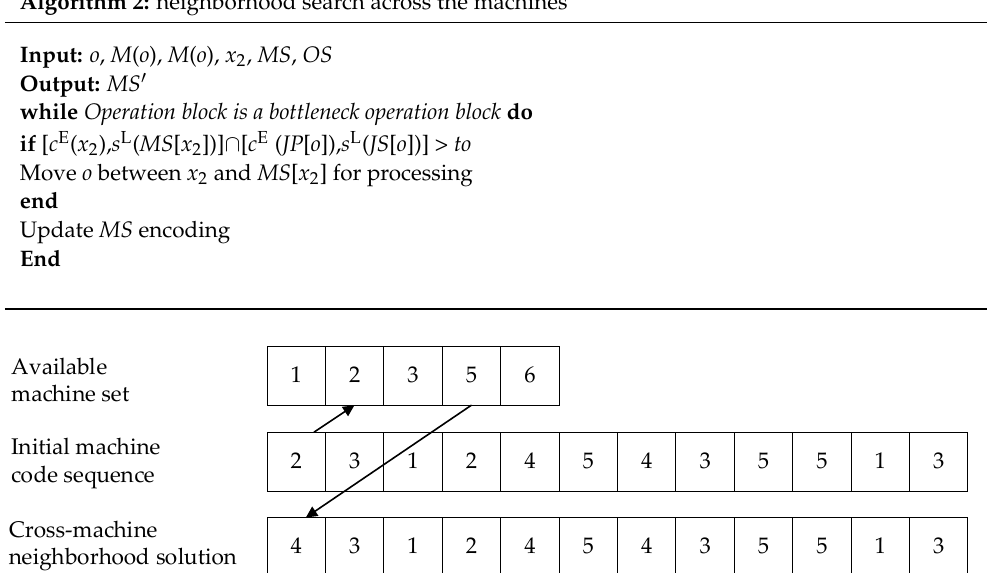
Algorithm 2: neighborhood search across the machines